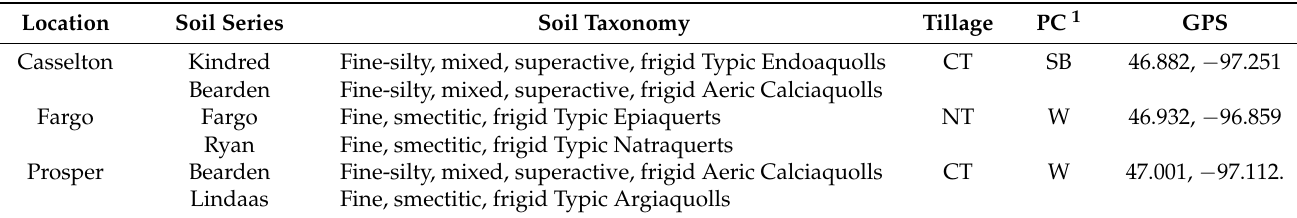
Table 1. Soil series, soil taxonomy, tillage system used, previous crop, and location coordinates for 12 environments in North Dakota, USA, in 2019 and